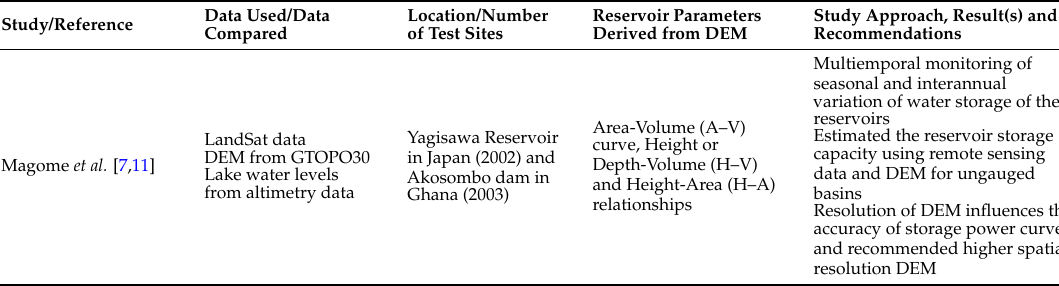
Table 1. Summary of literature review on reservoir storage capacity estimations and geometric analysis from digital elevation model (DEM) and related